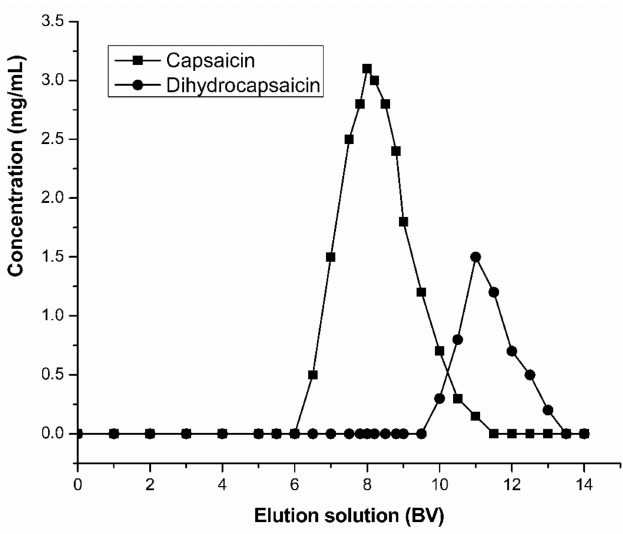
Figure 6. E ff ect of the elution solution on capsaicin separation. 0–2 BV: Distilled water; 2–4 BV:20% ( v / v ) ethanol / 80% ( v / v ) distilled water; 4–6 BV: 45% ( v / v ) ethanol / 55% ( v / v ) distilled water; 6–14 BV: 45% ( v / v )